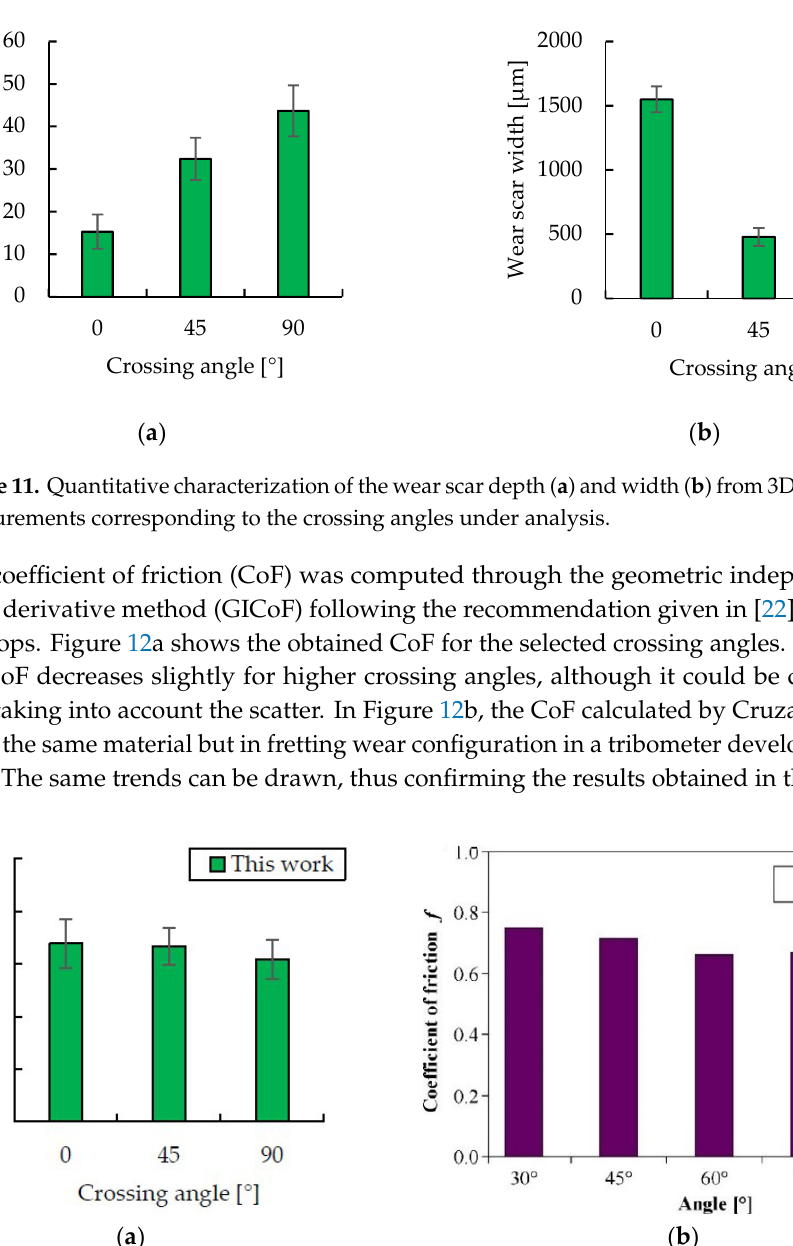
9 of 11 Figure 10. Evolution of the tangential force during tests and wear scar results: ( a ) 0° crossing angle; ( b ) 45° crossing angle; ( c ) 90° crossing angle; ( d ) comparison of the wear profile of each crossing angle test at 150 × 10 3 cycles. A typical flat topped-loop (Coulomb behavior) was observed for the 0° crossing angle test (Figure 10a), which remains constant throughout the entire test. Conversely, as the crossing angle increases (Figure 10b for 45° and Figure 10c for 90°), a more distorted loop is induced during the test, showing a non-Coulomb frictional behavior. It can be noted that this evolution toward a non- Coulomb behavior is more pronounced and occurs faster along the 90° test comparing to the 45° test. Figure 10d shows the wear scar profiles corresponding to the three crossing angle conditions (0°, 45°, 90°) and the numerical values are shown in Figure 11. It can be observed that the maximum wear scar depth (Figure 11a) increases with the crossing angle, while the width of the scar decreases (Figure 11b). The distortion of the fretting loop is therefore correlated with the wear scar evolution, since the test condition showing the biggest distortion (90°) is the one presenting a more pronounced wear scar. It has been reported by many researchers that sometimes the tangential force varies significantly